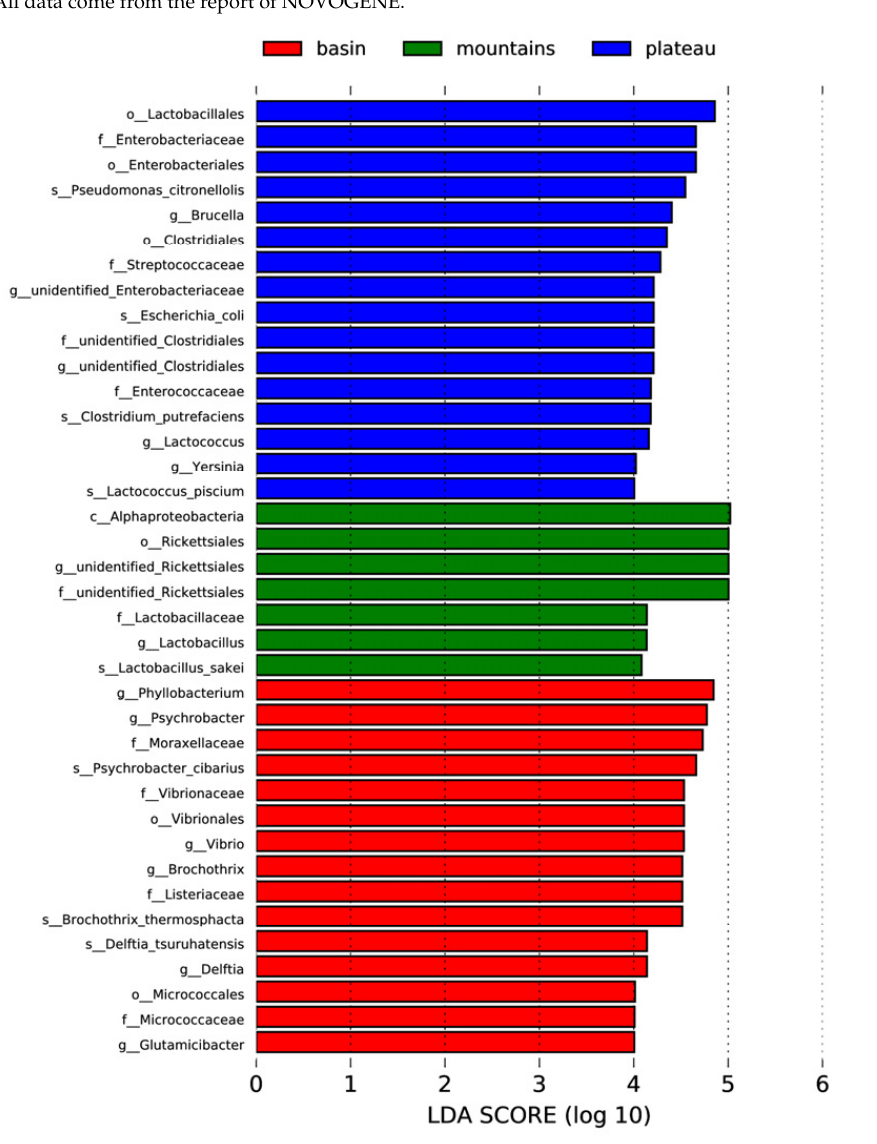
Figure A1. Significantly discriminant taxa (LDA score >4) among three regions of Sichuan bacon by LefSe